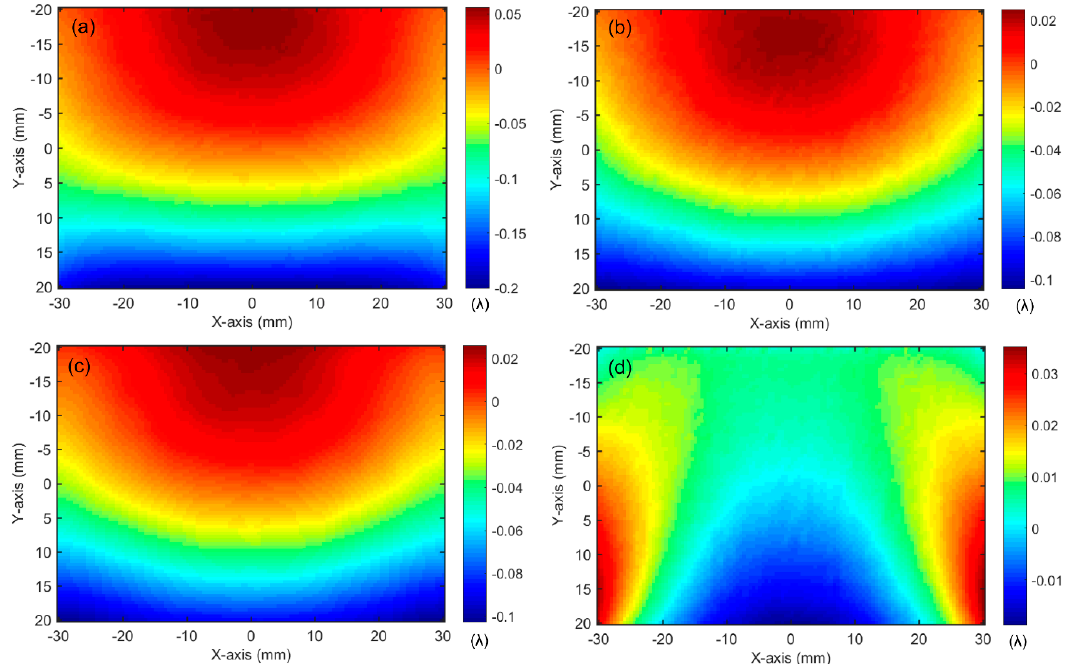
Figure 9. Calculated wavefront aberrations after single pass: ( a ) total wavefront aberration; ( b ) temperature-induced wavefront aberration; ( c ) stress-induced wavefront aberration; ( d ) deformation-induced wavefront aberration.